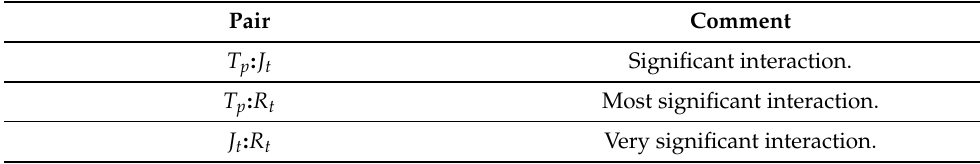
Table 14. Summarized RSA-based qualitative assessment of SDN metrics (pairwise